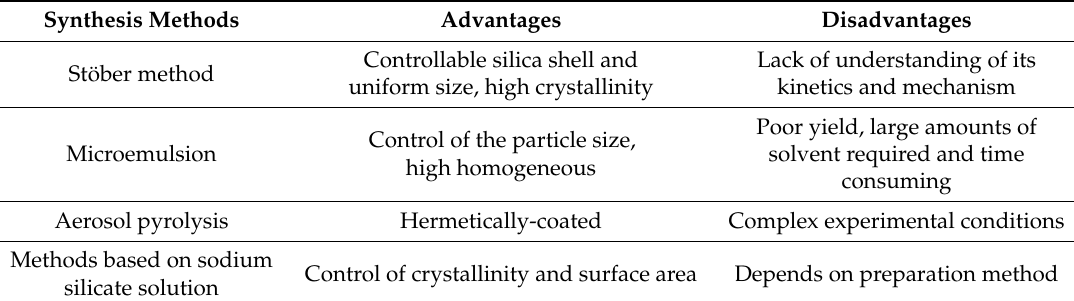
Table 2. Summary of synthesis methods for silica-coated IONPs.